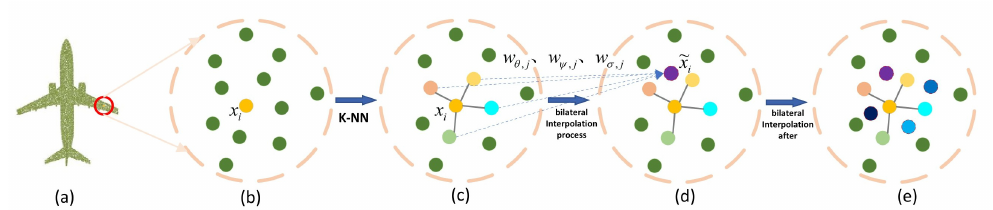
Figure 4. The operation process of learning-based trilinear interpolation. First, the similarity between pairs of points in the feature space ( b ) is defined from the complete point cloud ( a ). The k-nearest neighbors (k-NN) with defined similarity are selected in the feature space ( c ). Then, interpolation is performed in the neighborhood, and its interpolation process is shown in ( c , d ). Finally, a zoomed feature map is formed ( e